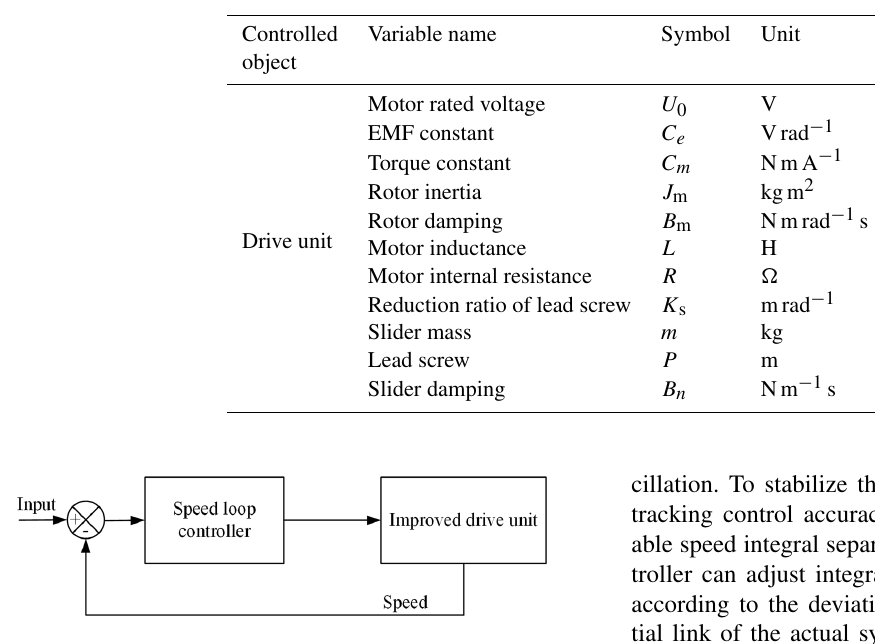
Figure 13. Block diagram of speed control